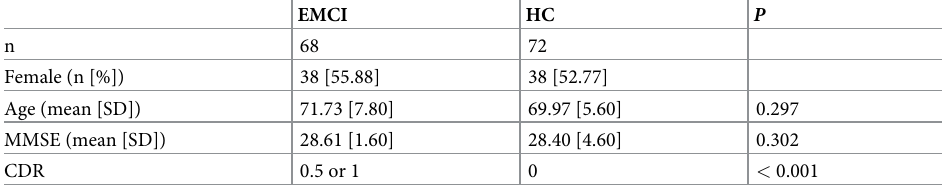
Table 1. Demographics of the data for participants included in this study.